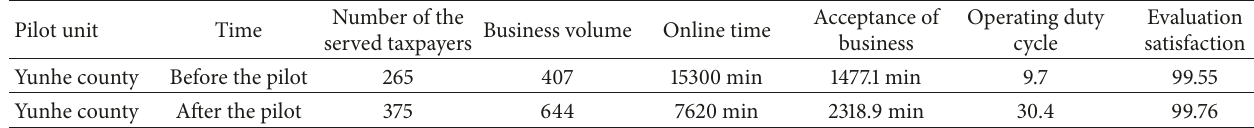
Table 5: Performance appraisal of flexible scheduling before and after the pilot (one